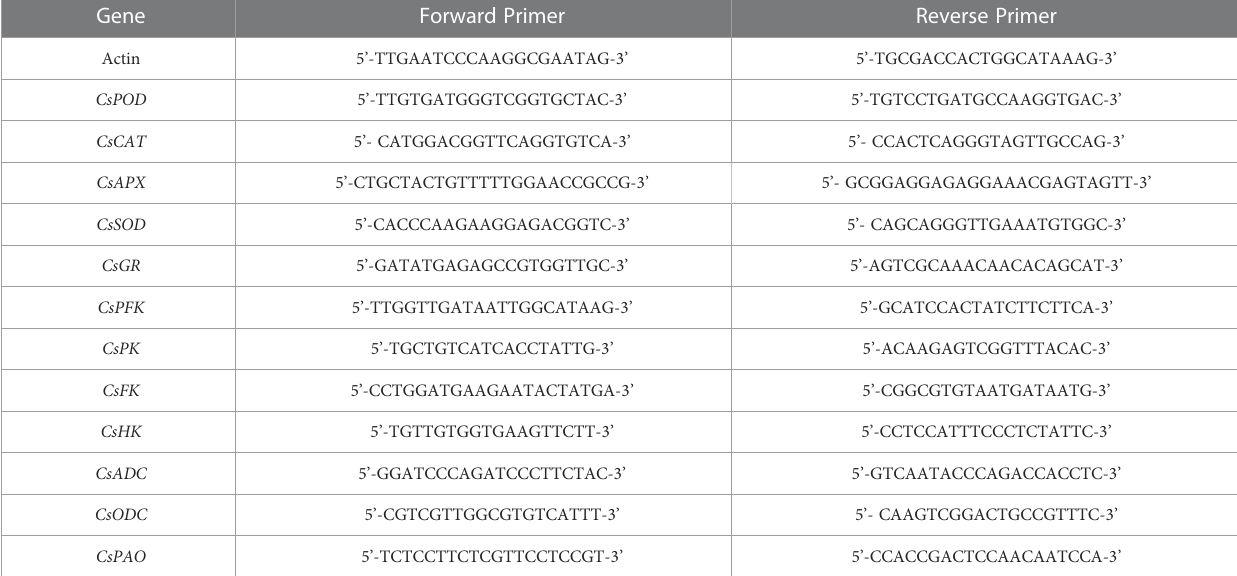
TABLE 1 Sequences of primers used for this